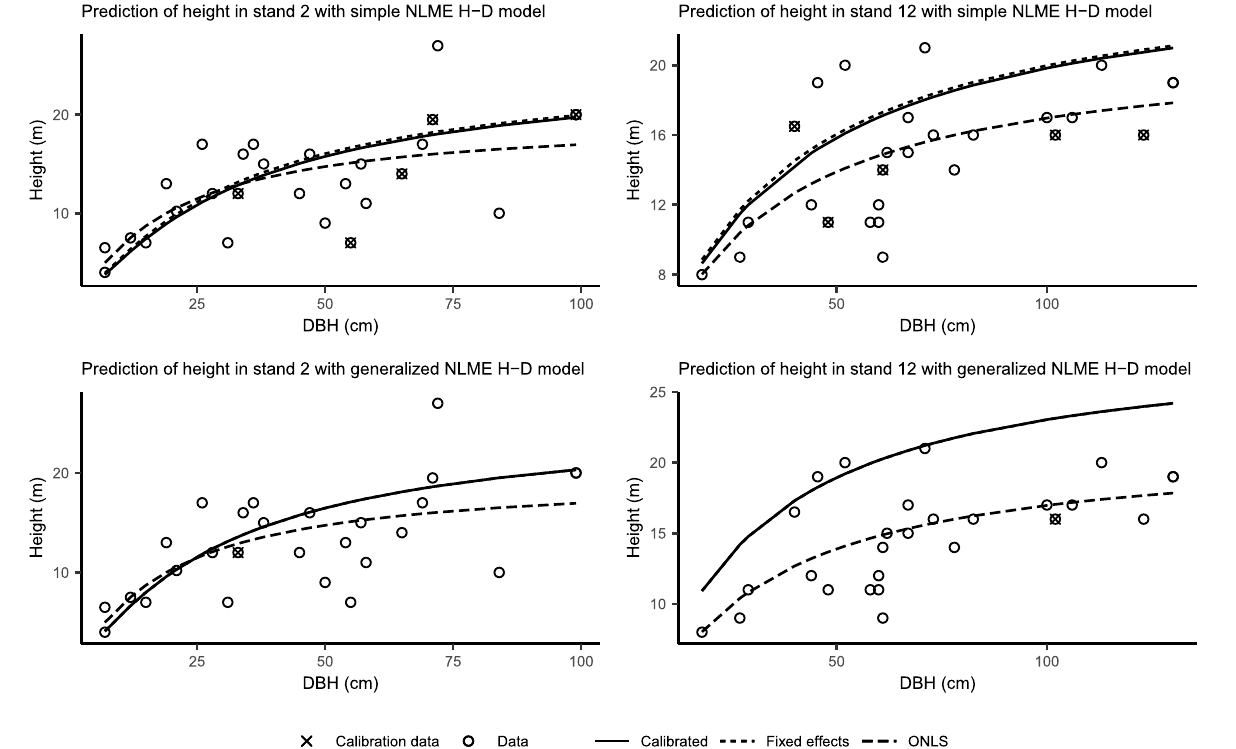
Fig. 8 Example of the calibration of simple NLME model with five sample trees and generalized NLME model with one sample tree in stands 2 and 12 compared to the fixed effects and ONLS prediction with simple H–D model and generalized H–D model of N. pumilio . The ONLS fits of generalized H–D model did not converge in either stand. Therefore, the generalized NLME model was likewise compared with the ONLS prediction of the simple H–D